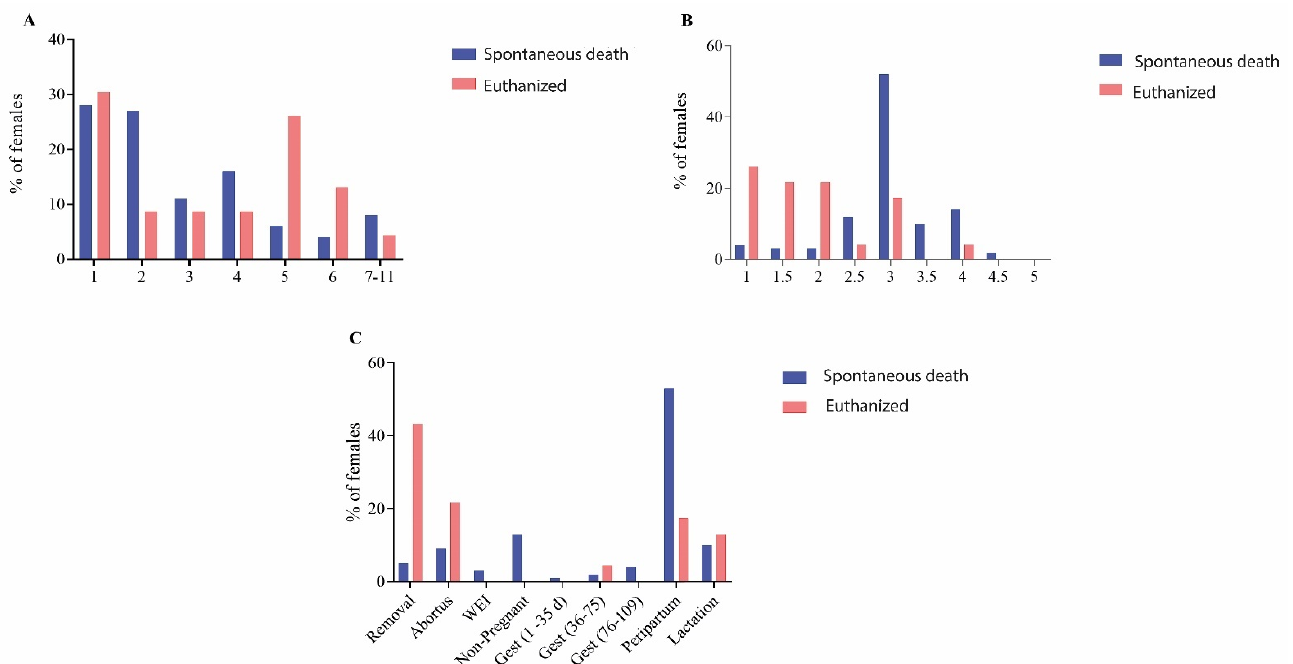
Table 1. Risk factors for post-mortem